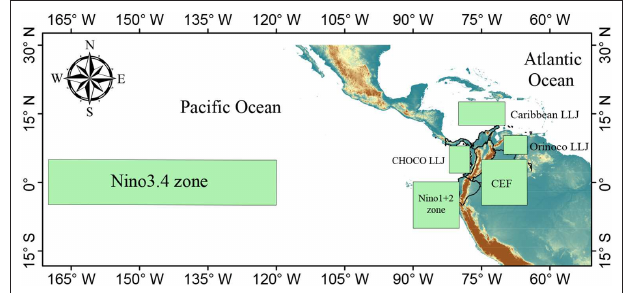
FIGURE 1 | Macro-climatic zones associated with the Colombian